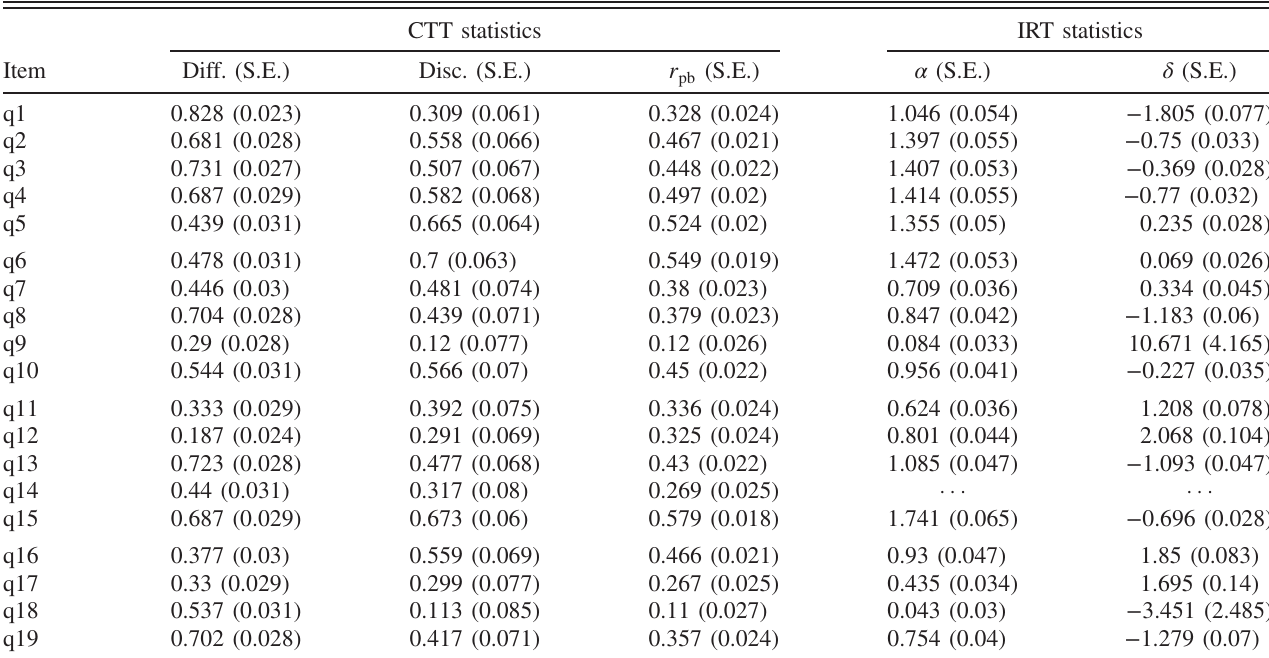
TABLE IV. BEMA ’ s CTT and IRT item parameters in the BEMA scale with standard